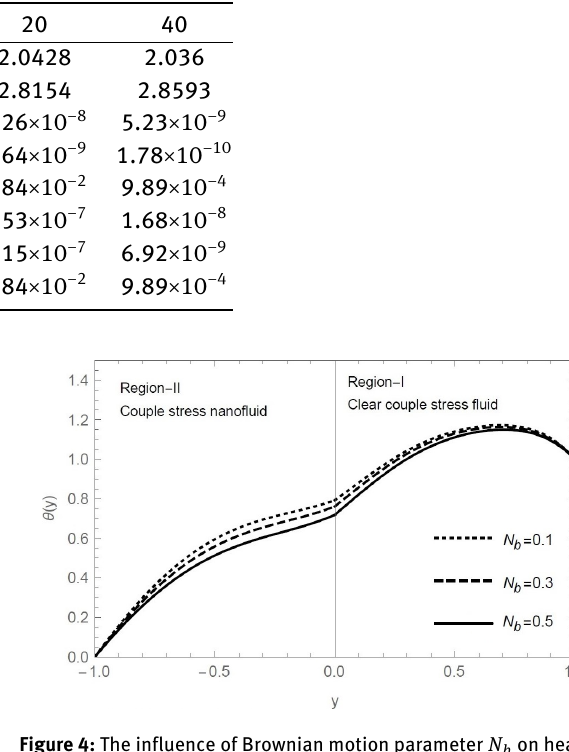
Figure 2: The influence of mixed convection parameter λ on fluids flow keeping Pr i = 2, h = 1, ξ i = Γ i = N b = 0.1, N t = δ i = 0.1 and µ = K = 0.5 .